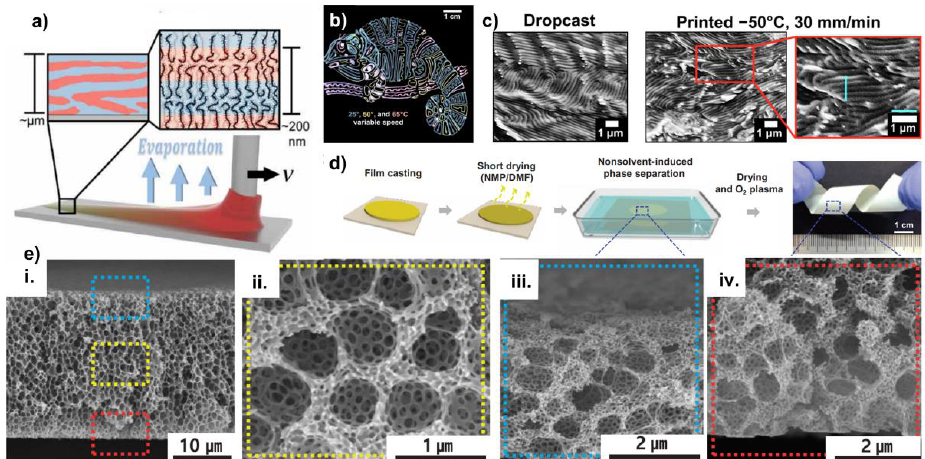
Figure 4. ( a ) Schematic diagram of the concept of the direct-write 3D printing [74] . ( b ) Change in photonic properties of the BBCP photonic crystals, depending on the temperature and printing speed [74] . ( c ) Formation of the morphologies during the drop casting and 3D printing [74] . ( d ) Concept of solvent drying for the formation of hyperporous nano membranes [75] . ( e ) (i – iv) Mem- brane morphologies along the lateral direction of the film [75] . Adapted with permission from ref- erences [74,75] .